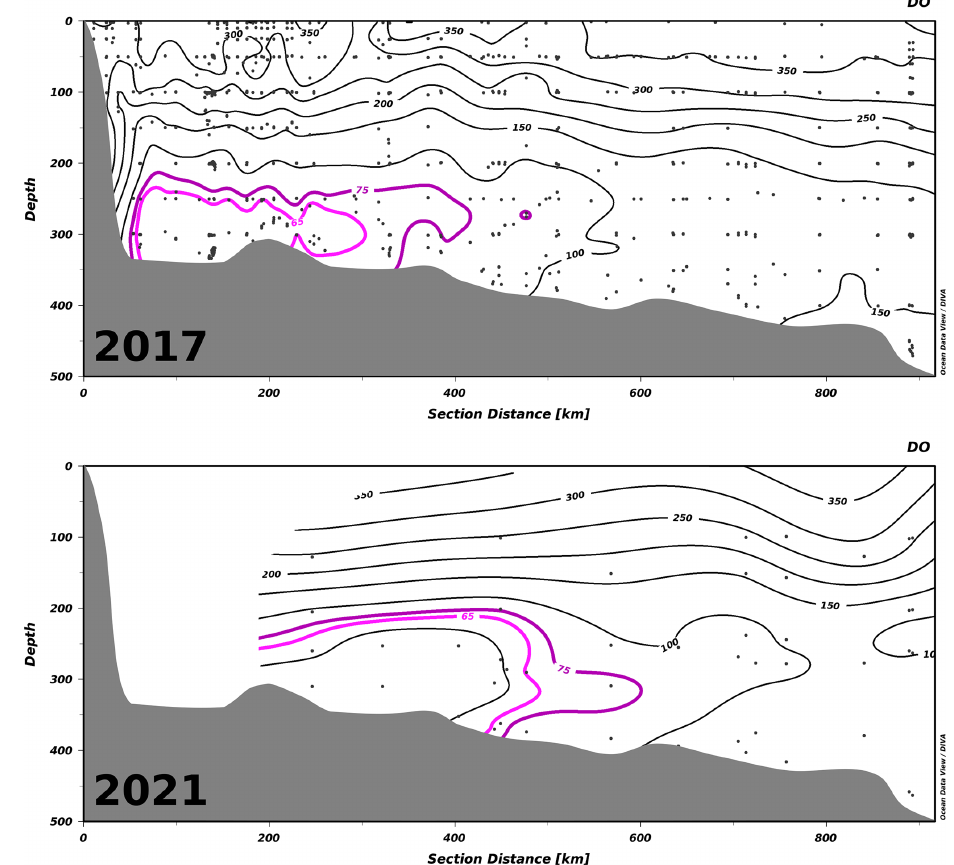
Figure 5. Transects of all dissolved oxygen (DO) concentration measurements along the Laurentian Channel – sampled in spring, summer and fall of 2003, 2009 and 2017 and in summer and fall of 2021 – from the head of the channel (left) to Cabot Strait (right). Black dots indicate the location of measurements. Contours show DO concentrations (in µM). The hypoxic waters are delineated with the magenta contour. Zones with no data are left blank.